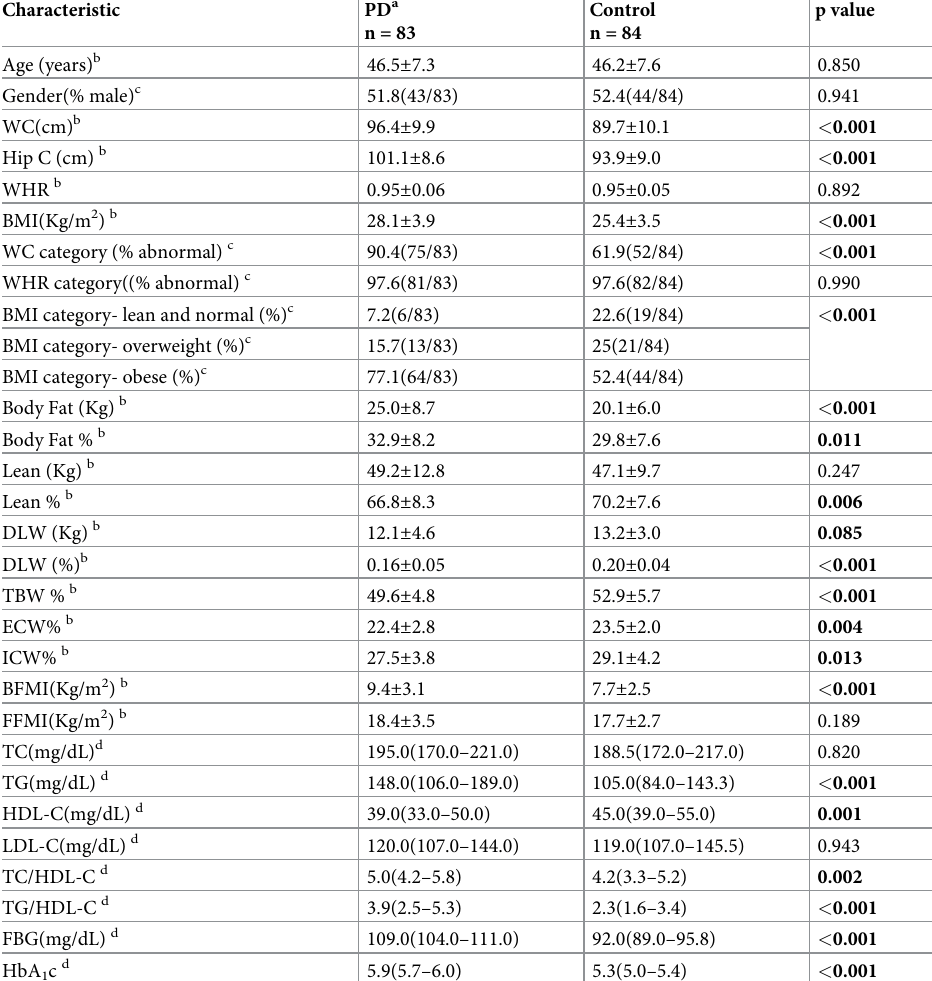
Table 1. General, anthropometric, body composition and metabolic characteristics of the PD and control